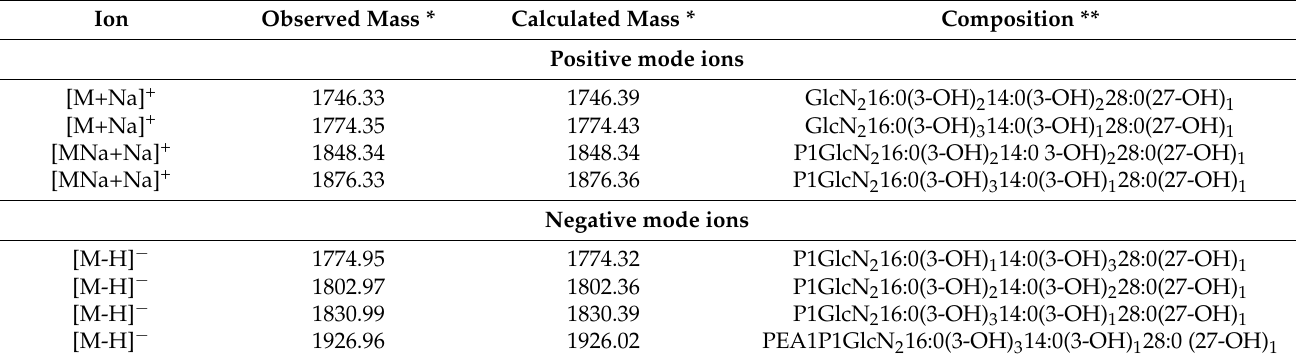
Ions marked with an obelisk denote bis-sodiated species. Ions marked with an asterisk denote tri-sodiated species.* Exact mass values. ** Other fatty acyl combinations may be possible, however, the ones given are those that include the major fatty acyl components observed.